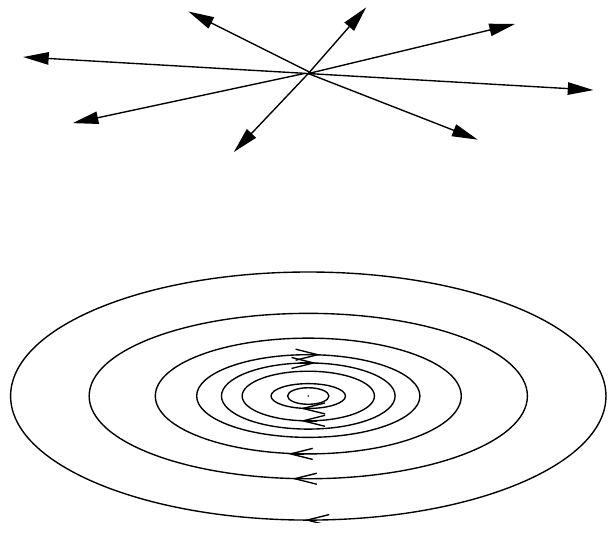
Fig. 1. Schematic presentation of curl-free (upper) and divergence- free (lower) Cartesian elementary current systems